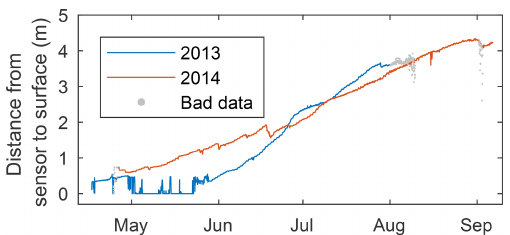
Figure 14. Distance from the acoustic sensor to the snow or ice surface. Increasing distance is a result of snow or ice melt and snow settling. Decreasing distance is due to snow accumulation. In early August 2013, the sensor’s mounting pole began to tip over and give bad readings. On 1–2 September 2014, 18cm of snow accumulation was recorded, consistent with observations during a site visit. The sensor pinged off falling snow, so some points in that window are labeled as bad